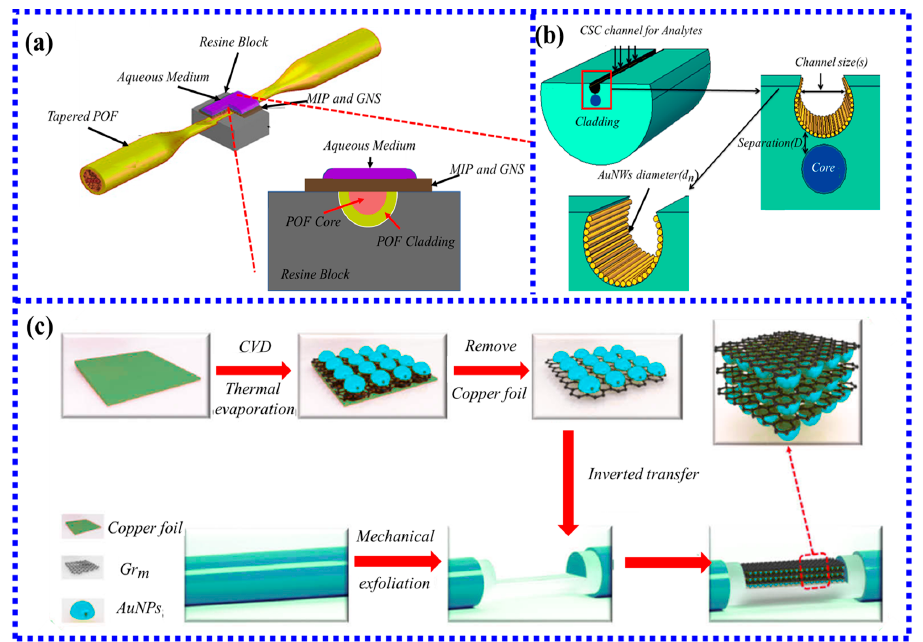
Figure 13. Schematic diagram of the optical sensor system based on LSPR in D-type fiber: ( a ) tapered platform with sensing layer of five-branched gold nanostars and molecularly imprinted polymers [90]. Copyright 2023, Elsevier; ( b ) fiber-optic sensor covered with multiple Au nanowires [91]. ( c ) Schematic of the preparation procedure of n*(Grm/AuNPs)/D-POF [92].